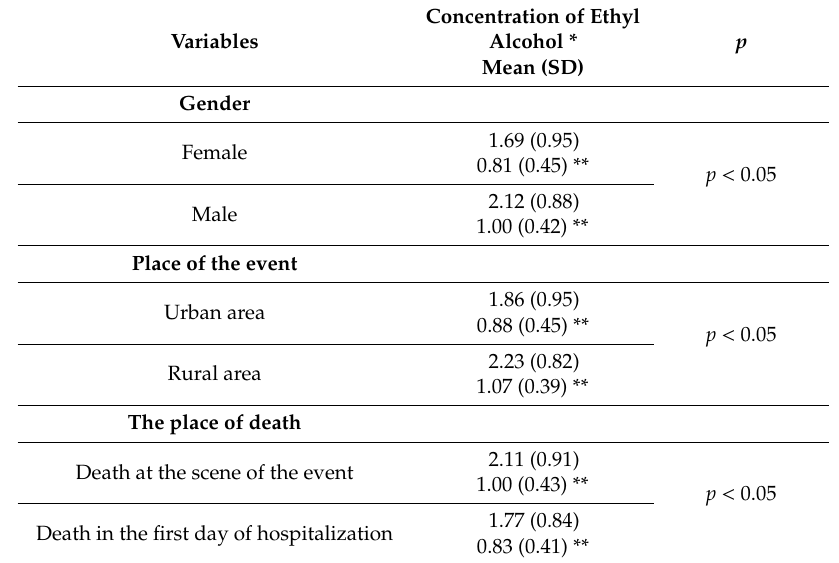
Table 3. Analysis of the relationship between alcohol levels and gender, place of event, and place of